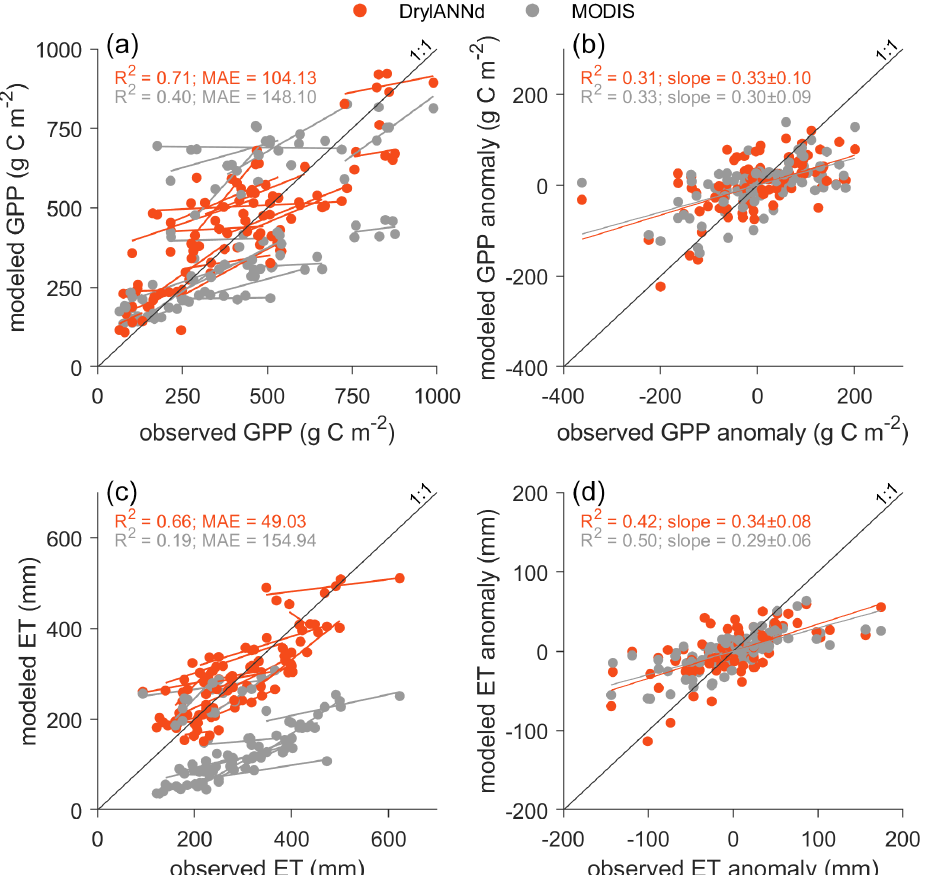
Figure 7. Annual and interannual variability in warm season (April–October) (a,b) GPP and (c,d) ET. The orange and gray lines in (a) and (c) show the linear relationship between estimated and observed GPP and ET for each individual site during the 6-year training and evaluation period, while lines in (b) and (d) show the linear relationship between estimated and observed GPP and ET anomalies across all sites. For purposes of calculating annual values and anomalies, missing monthly data were filled with a spline